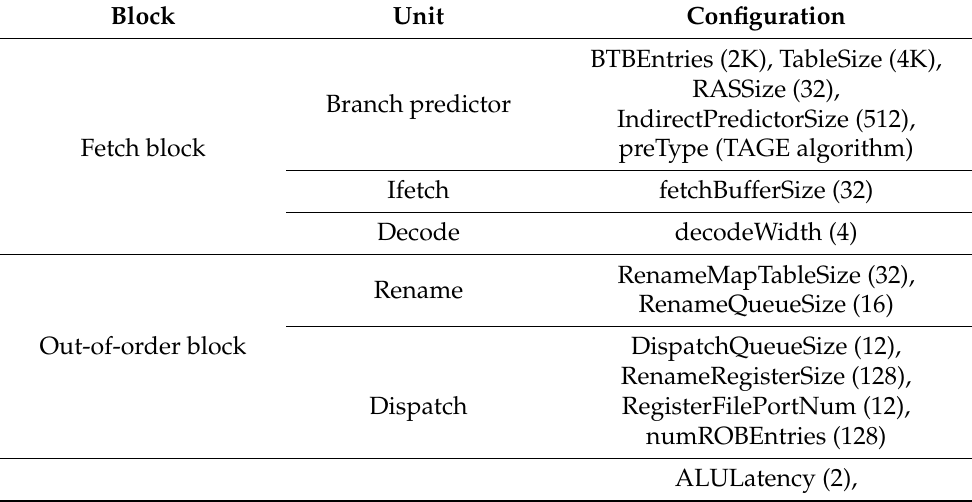
Table 3. Design option examples for PNX processor